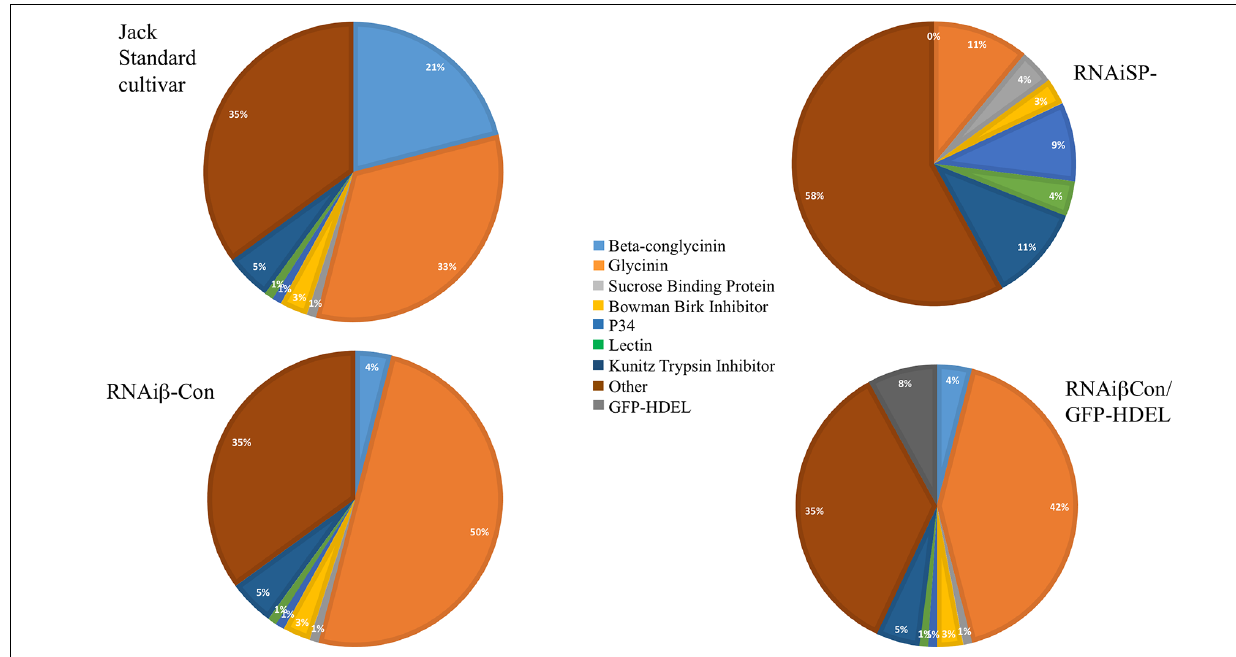
FIGURE 1 |Variations of seed composition within the context of the protein content genotype are shown. The pie charts show the relative distribution of proteins comprising the seed proteome of the standard soybean line Jack, a line that silences β -conglycinin α , α (cid:2) , another line that silences both β -conglycinin and glycinin, and a line where GFP-HDEL